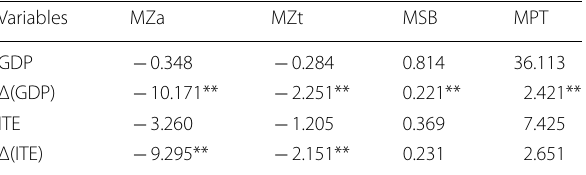
Table 3 Unit root test without structural breaks (Ng-Perron) for the model with the constant only